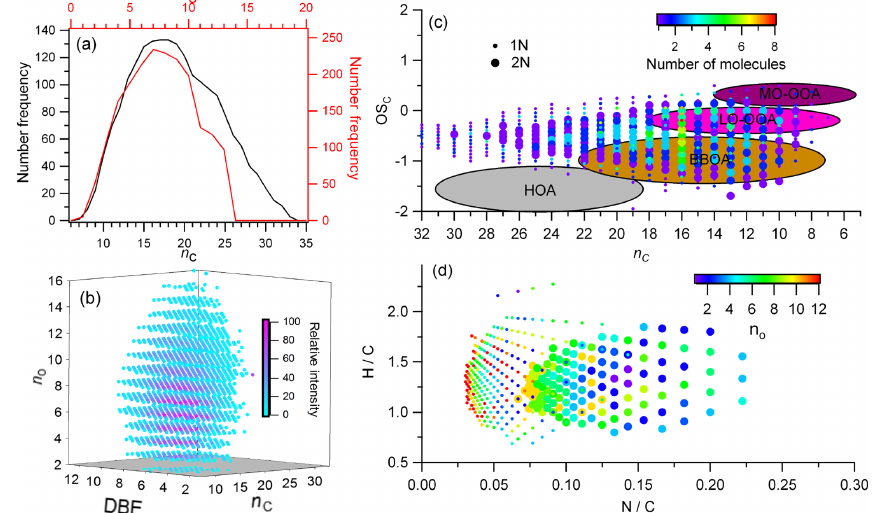
Figure 5. The molecular information for common CHON compounds. (a) The number frequency distribution of carbon ( n c ) and oxygen ( n o ) . (b) The 3-D plot for n o , n c , and double bond equivalents (DBEs) colored by their relative intensity. (c) Scatter plot of carbon-based oxidation state (OSc) vs. n c colored by the distribution of number of molecules. (d) The Van Krevelen diagram by H / C vs. N / C colored by number of oxygen ( n o ) . The different sizes of dot marker in (c) and (d) represent the 1N and 2N compounds.